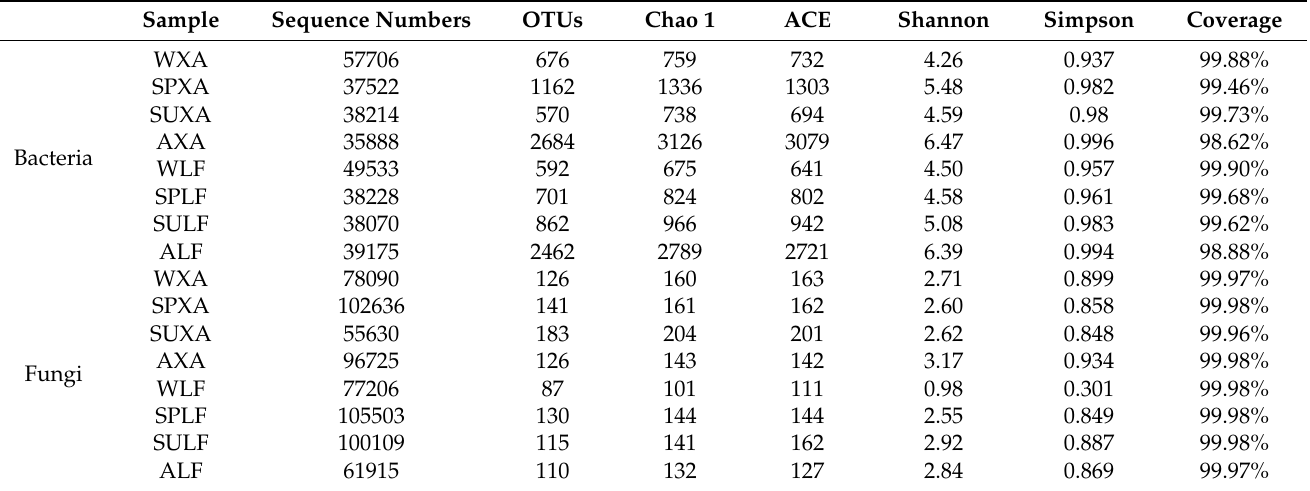
Table 1. Comparison of species estimators of the bacterial and fungal communities in PM 2.5 in different